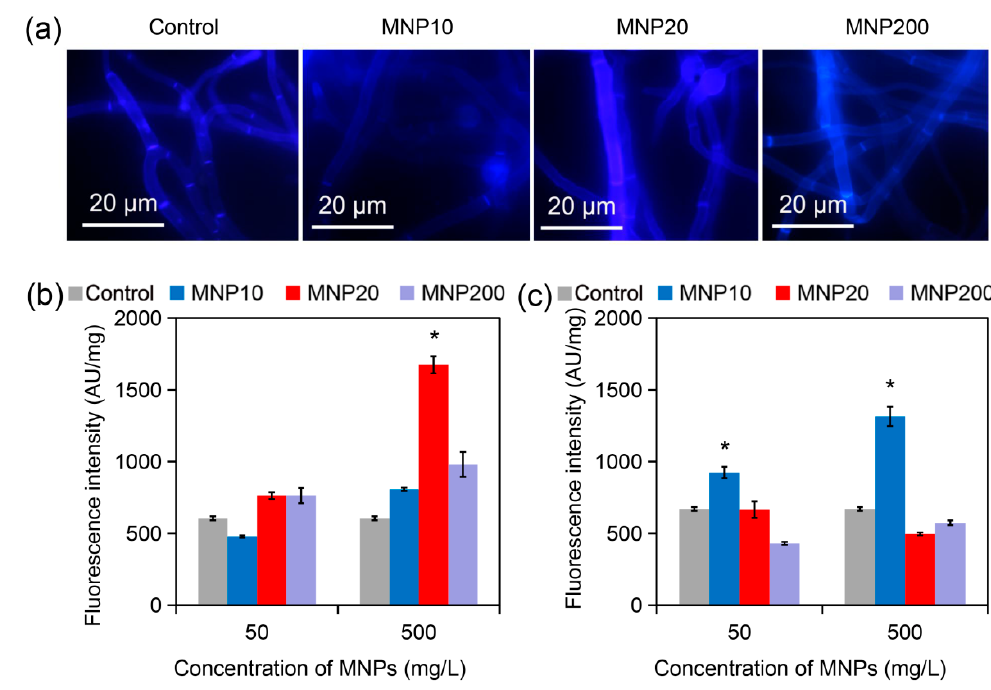
Figure 3. Observation and analysis of cell wall components in A. niger treated by the MNPs for two days. ( a ) Fluorescence microscope images of the A. niger hyphae. The hyphae were treated by the MNPs (500 mg/L) for two days, harvested and stained by CFW for observation of chitin distribu- tion. ( b ) Cell wall chitin contents of the treated hyphae revealed by CFW staining and fluorescence quantification. ( c ) β -glucan contents of the treated hyphae revealed by aniline blue staining and fluorescence quantification. The asterisks (*) indicate significant difference between the MNP20 group and other groups ( p < 0.05).